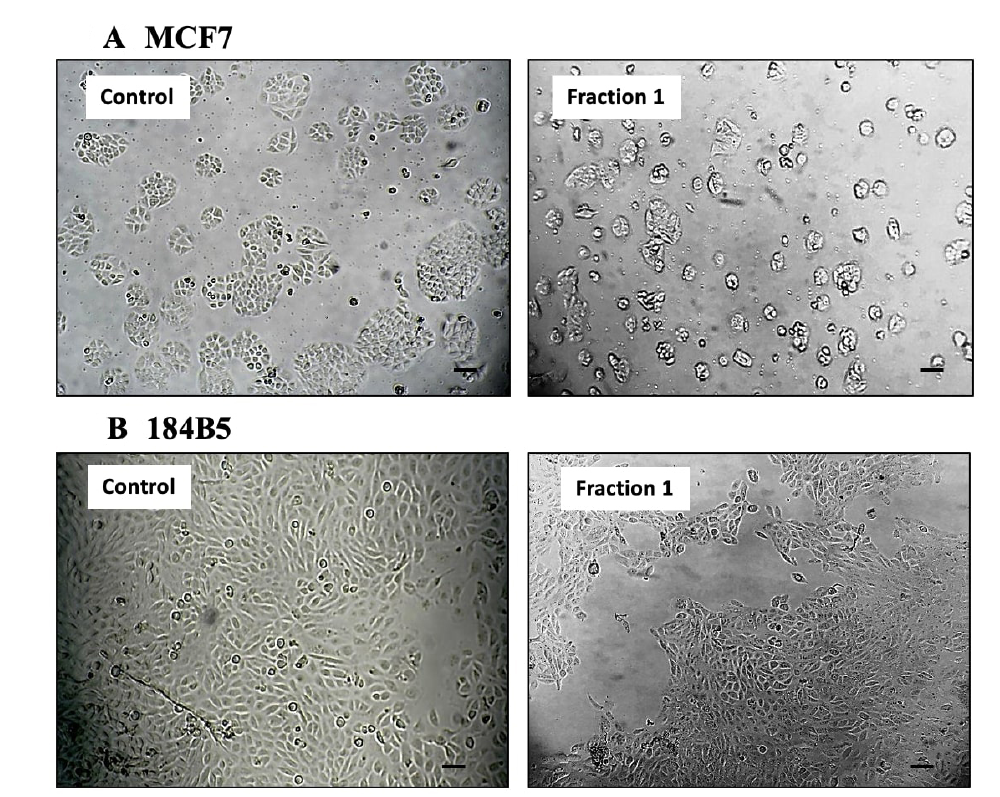
Figure 5. Morphological changes in human breast cell lines, (A) MCF7 (cancerous) and (B) 184B5 (normal) after 72-hour treatment of Fraction 1 (purpureomaculin) of Trimeresurus purpureomaculatus venom. Scale bars = 30 µm.